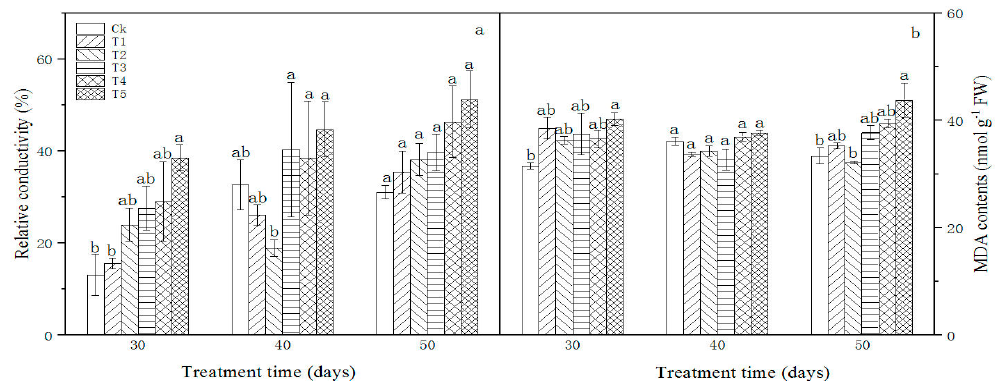
Figure 4. Relative conductivity ( a ) and malondialdehyde (MDA) contents ( b ) of L. olgensis leaves treated with different concentrations of graphene (mean ± 1 S.D., n = 3). Values followed by the same letter for the same days are not significantly different at p < 0.05. Ck, T1, T2, T3, T4 and T5 represent 0, 25, 50, 100, 250, and 500 mg L -1 graphene treatments, respectively.